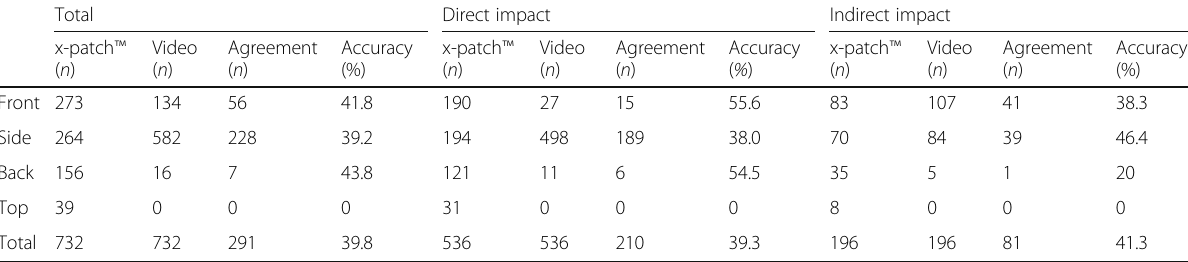
Table 3 Video-verified impacts: location accuracy of direct and indirect impacts Total Direct impact Indirect impact x-patch ™ ( n